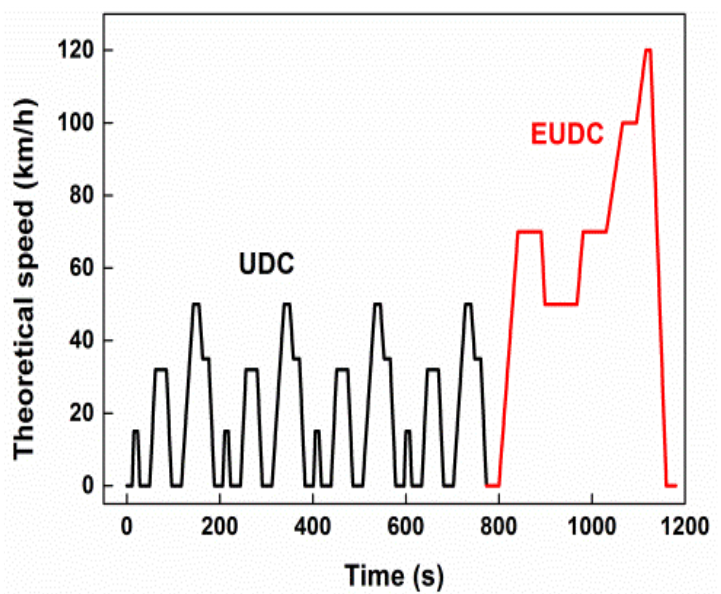
Figure 2. The vehicle speed during the NEDC cycle.